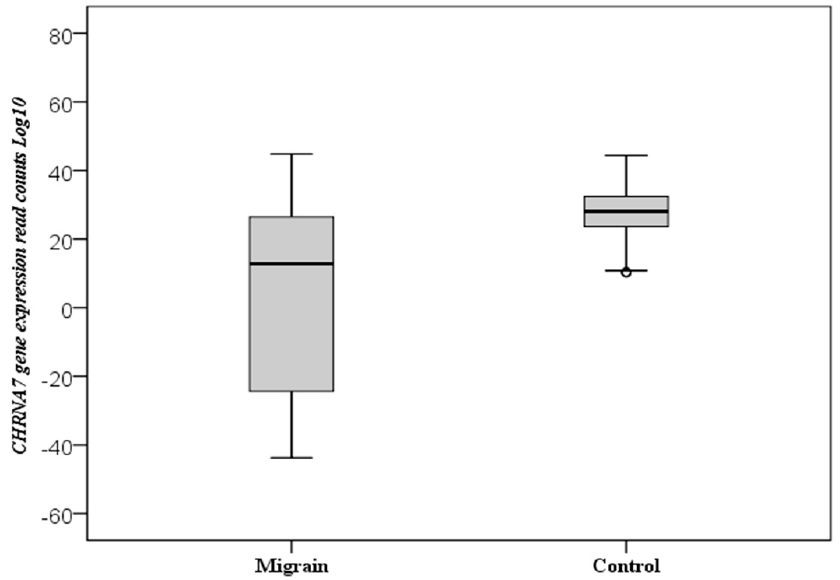
Figure 1. Boxplot of the CHRNA7 gene expression. The total numbers of miRNA reads are log10 transformed. The circles represent outliers.